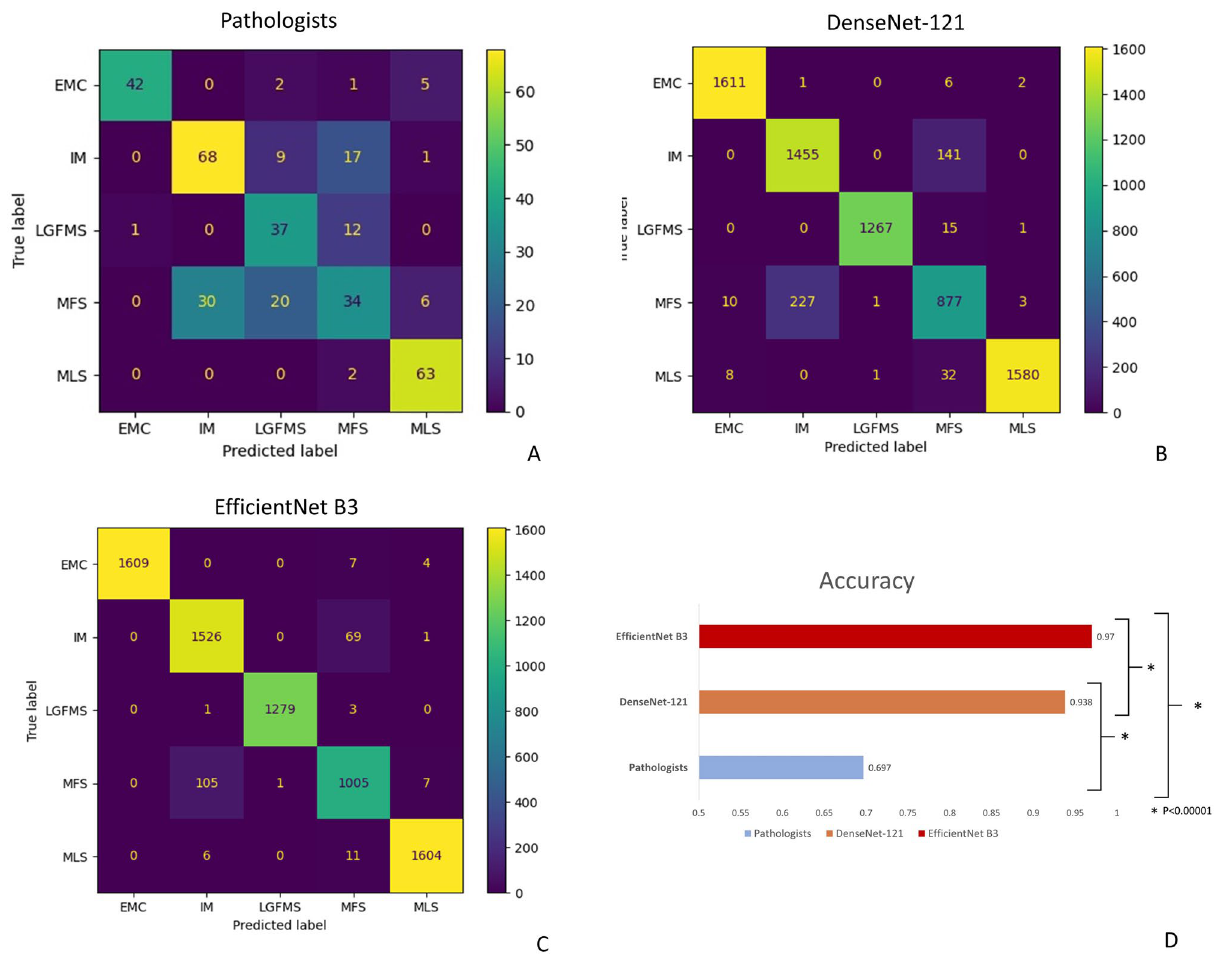
Figure 1. Confusion matrix of pathologists ( A ), DenseNet-121 ( B ) and EfficientNet B3 ( C ). Both deep learning models have significant improvement in accuracy compared to pathologists ( D ), and EfficientNet B3 has a small significant further improvement compared to DenseNet-121. EMC extraskeletal myxoid chondrosarcoma, IM intramuscular myxoma, LGFMS low grade fibromyxoid sarcoma, MFS myxofibrosarcoma, MLS myxoid